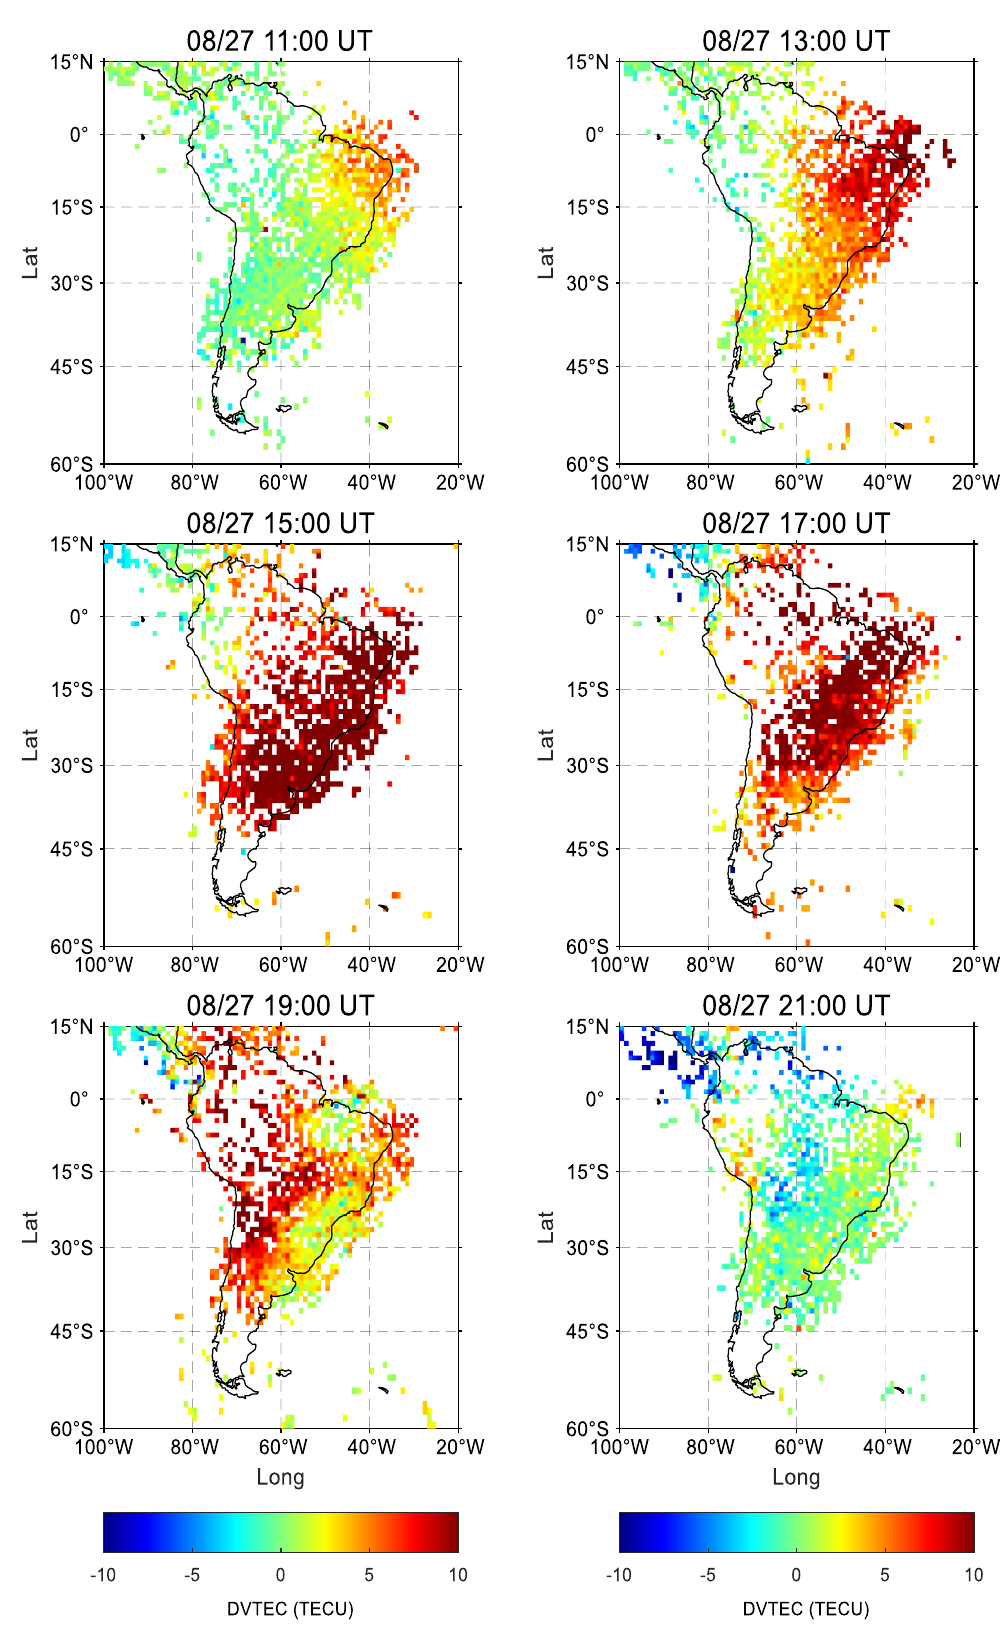
Figure 9. Spatiotemporal evolutions of storm-4.